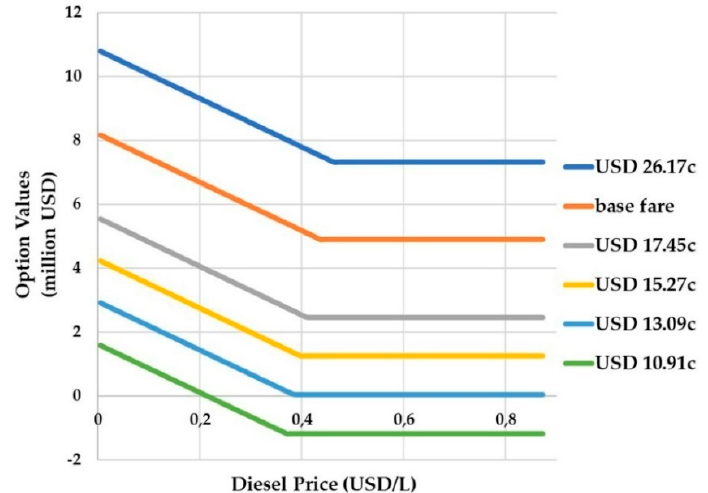
Figure 4. Option values at different jeepney fares. Current base fare = USD 21.81c (PHP 10); USD 26.17c adds PHP 2 onto the base fare); USD 17.45c, 15.27c, 13.09c, and 10.91c reduce the current base fare by PHP 2, PHP 3, PHP 4, and PHP 5 (USD 1 = PHP 45.85). Optimization results are tabulated in